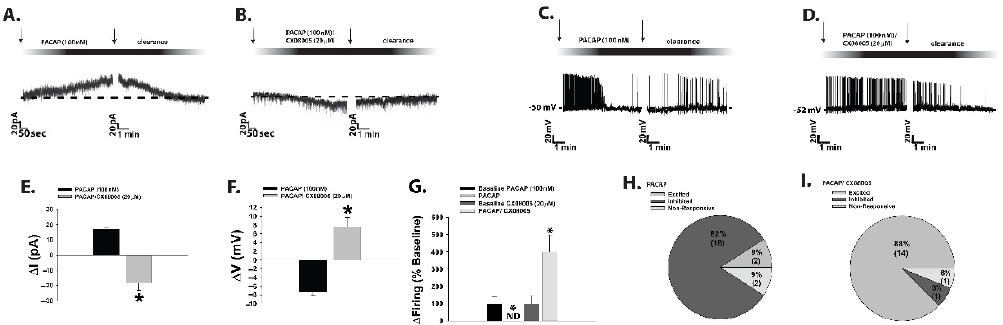
Figure 6. The fasting-induced switch in the polarity of the PACAP response in POMC neurons involves the activation of protein tyrosine phosphatases. Representative traces show that the PACAP-induced outward current ( A ; n = 12) and hyperpolarization ( C ; n = 10) seen under fasting conditions reverts back to an inward current ( B ; n = 9) and depolarization ( D ; n = 7) in the presence of the PTP1B/TCPTP inhibitor CX08005 (20 μ M; B ). This is further substantiated by the composite bar graphs in ( E – G ) as well as the pie charts in ( H , I ). Bars represent means, and lines 1 SEM of the PACAP-induced change Δ I, Δ V or normalized firing rate under fasted conditions, alone and in combination with CX08005, Compound C or metformin. * p < 0.05, relative to PACAP alone, Student’s t-test ( E,F ); relative to baseline, Kruskal–Wallis/median-notched box-and-whisker analysis ( G ).